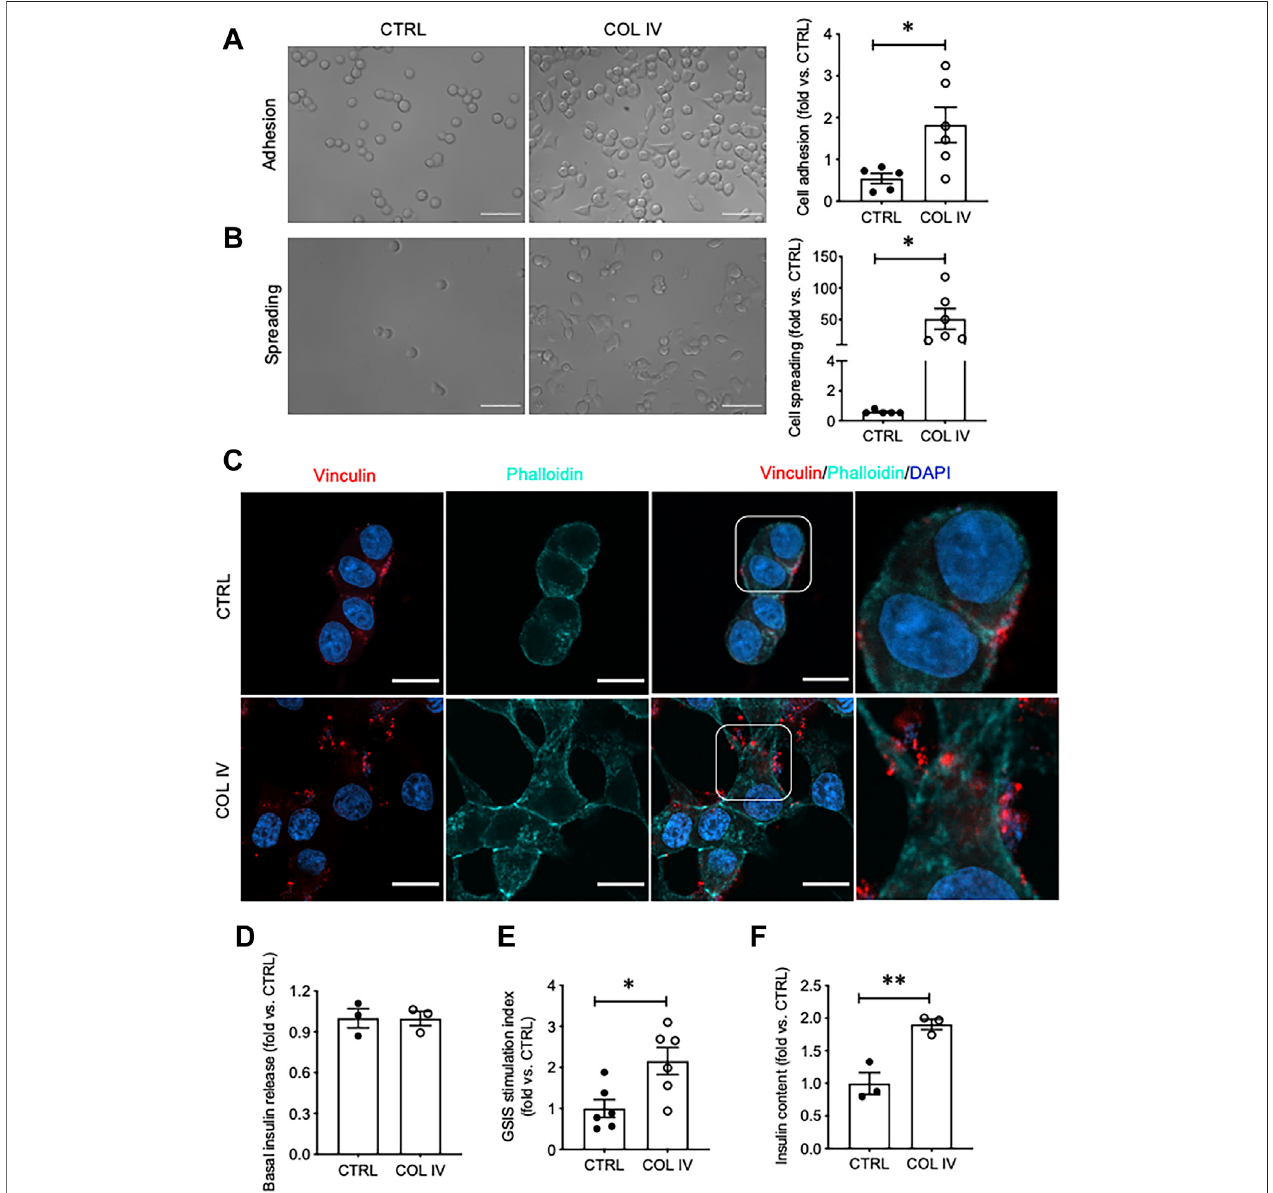
FIGURE1 | Collagen IV enhances INS-1 cell adhesion, spreading, focal adhesion, and insulin secretion. Phasecontrast images of INS-1 cells cultured on collagen IV (COL IV) or BSA-coated control (CTRL) and quanti fi cation of cell (A) adhesion and (B) spreading. Scale bar: 50 µm. * p < 0.05 vs. CTRL, data are expressed as fold changevs. control(mean±SEM, n =6experiments/group). (C) Immunostainingforvinculin(red)and F-actin(cyan)ofINS-1cellsculturedonCOLIV-andCTRL-coated chamber slides for 24 h. Nuclei are counterstained with DAPI, and magni fi ed images are highlighted. Scale bar: 10 µm. (D) Basal insulin release, (E) glucose stimulatedinsulinsecretion (GSIS)stimulation indexand (F) cellularinsulincontentfromINS-1cellscultured onCOLIVorCTRL.* p < 0.05,** p < 0.01vs.CTRL.Dataare expressed as mean ± SEM ( n = 3 – 6 experiments/group).